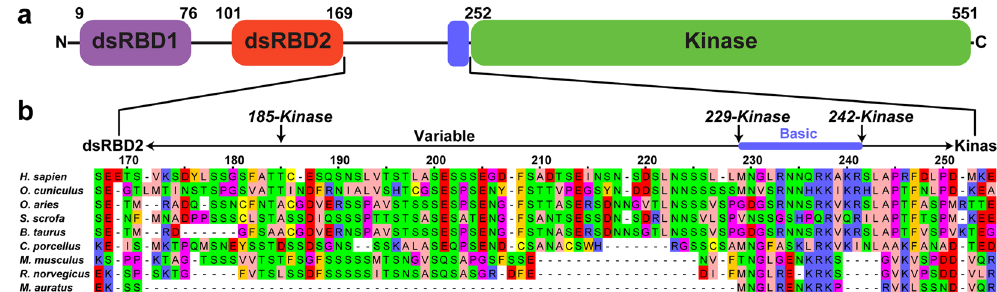
Figure 1. PKR domain schematic. ( a ) PKR domain organization. Canonical domain boundary positions are indicated above each domain. ( b ) Linker sequence alignment. The alignment was generated with ClustalW 55 and prepared in JalView 56 . Residues are colored using the Zappo coloring